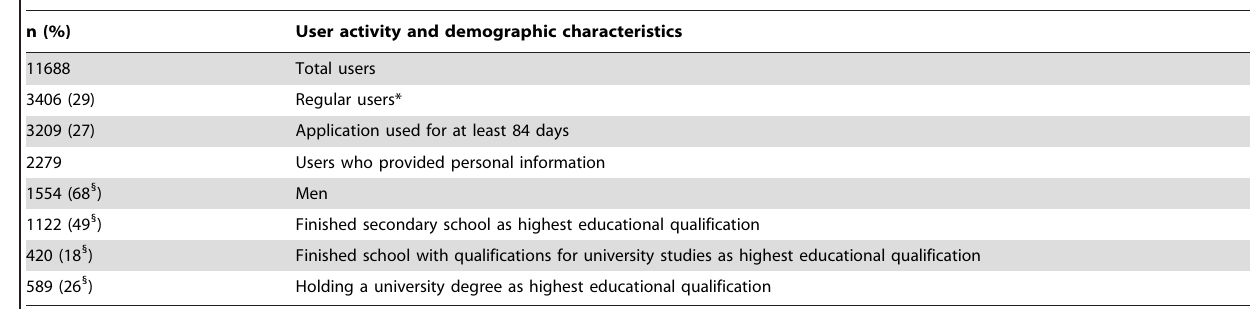
Table 1. User activity over time and demographic characteristics in smartphone users, who downloaded and used "Medication Plan from 12/14/2010 - 04/02/2012 (* regular use was defined as using the application at least once a week for at least 28 days, 1 percent of 2279 users who provided personal